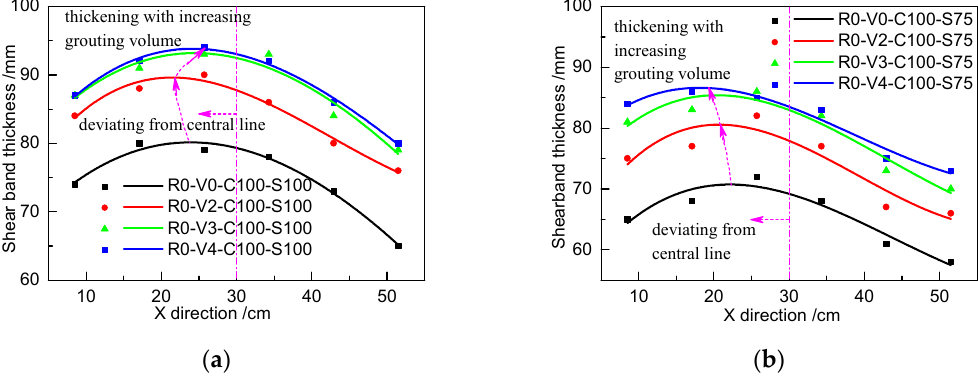
Figure 17. Relationship of the distribution and thickness of the shear band with different grouting volumes in different loading cases: ( a ) C100 and S100 and ( b ) C100 and S75. Table 9. Average shear band thickness for specimens with R0 under different grouting conditions